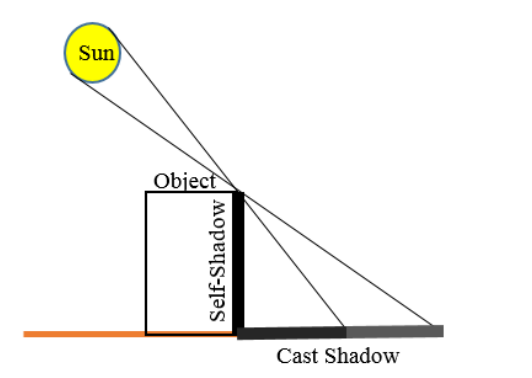
Figure 1. Shadow formation and its